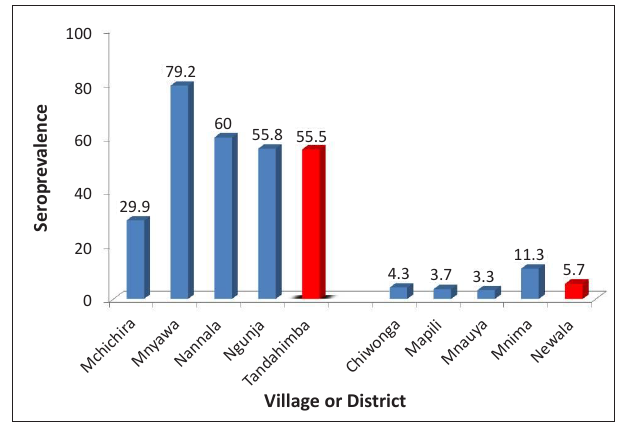
FIGURE 2: Seroprevalence by villages or district.